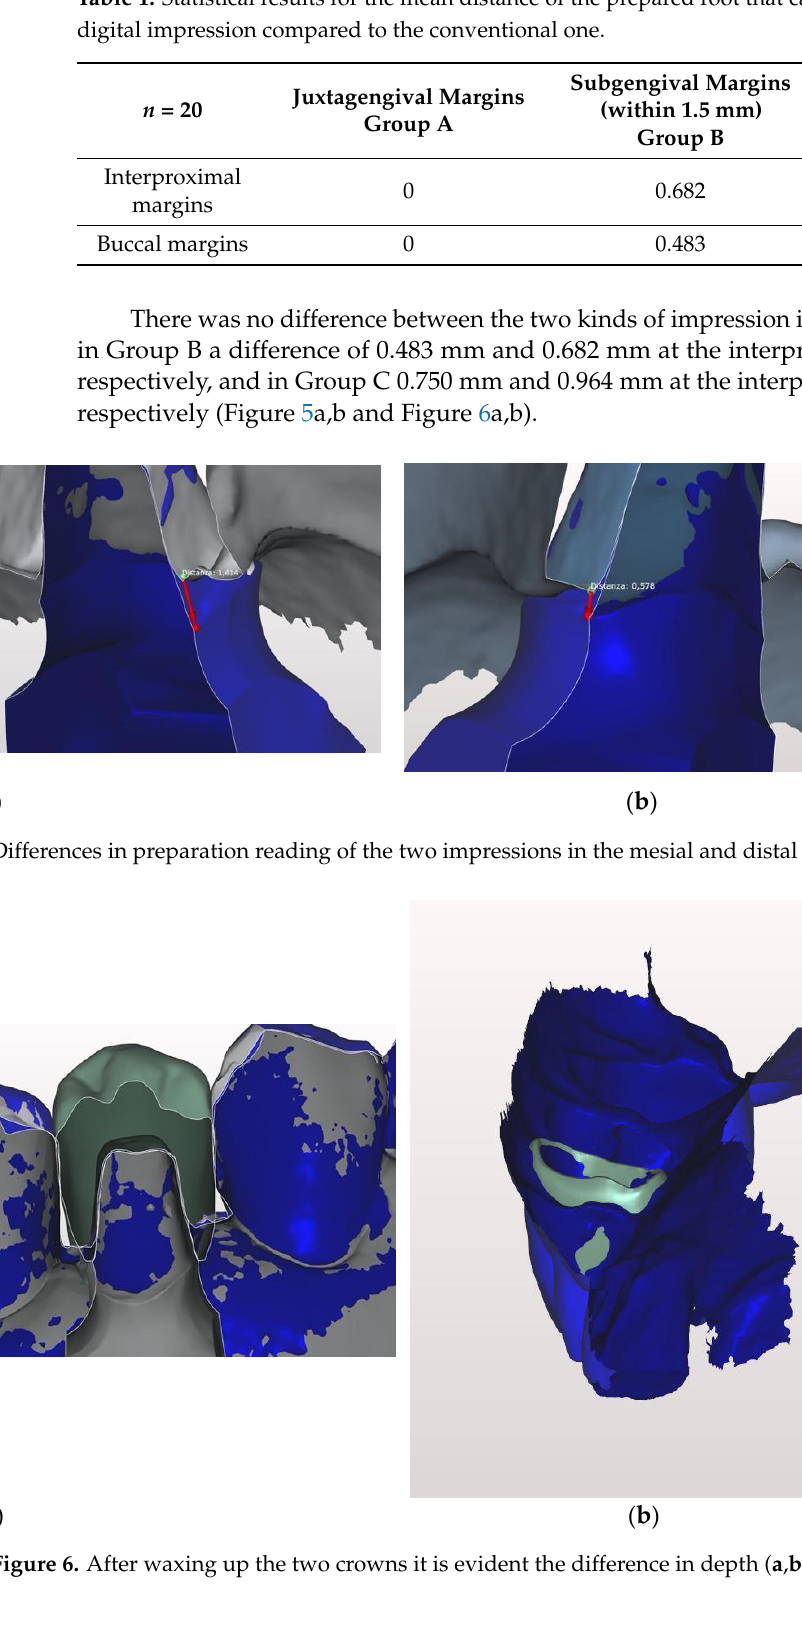
Table 1. Statistical results for the mean distance of the prepared root that cannot be detected with the digital impression compared to the conventional one.